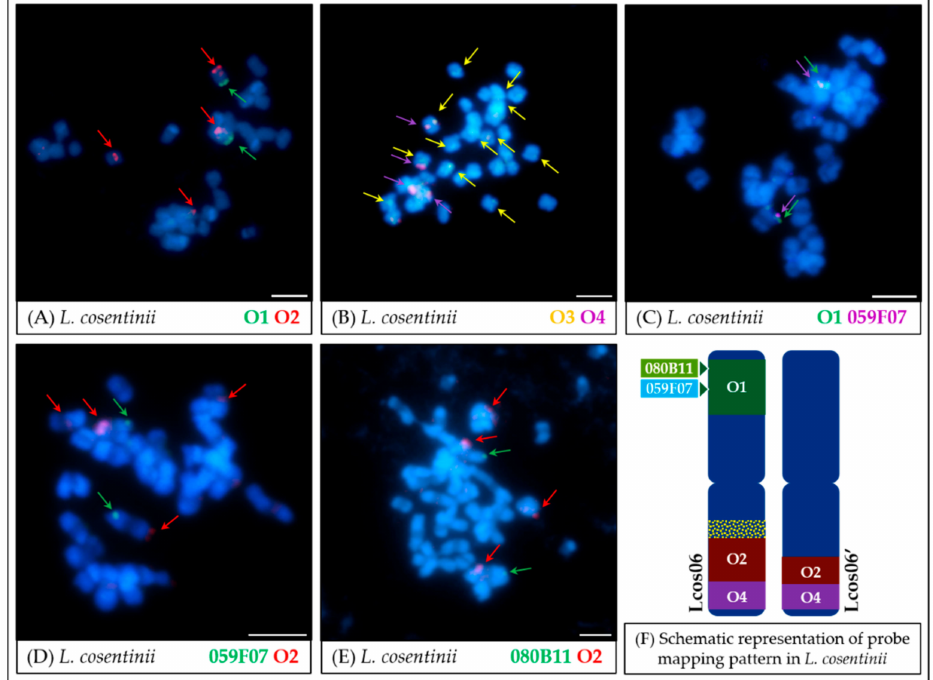
Figure 6. FISH mapping results of oligonucleotide probes ( A , B ) and oligonucleotide combined with BAC clones ( C – E ) in mitotic chromosomes of L. cosentinii. The positions of individual probes are marked by arrows. Probe colors are as follows: green (O1, Lang06 arm A), red (O2, Lang06 arm B), yellow (O3, pericentromeric region of Lang06 arm B), and purple (O4, telomere region of Lang06 arm B). Scale bar: 5 µ m. Schematic representation of probe mapping pattern in L. cosentinii chromosomes ( F ), showing observed positions of particular oligonucleotide-based or BAC-based probes, was not drawn to scale. The O3 probe hybridized to multiple